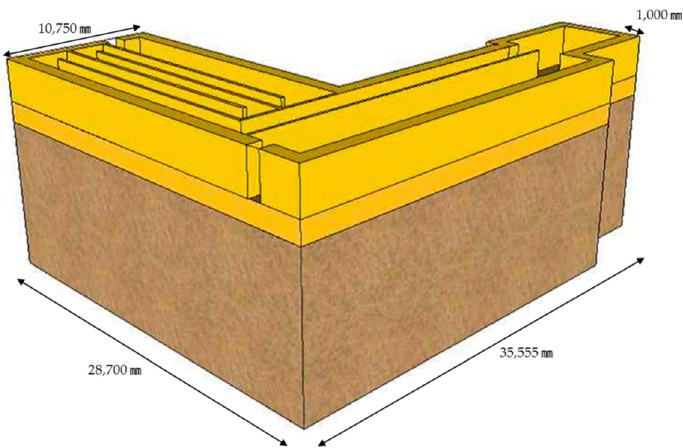
Figure 2. Earth modeling for thermal labyrinth analysis.